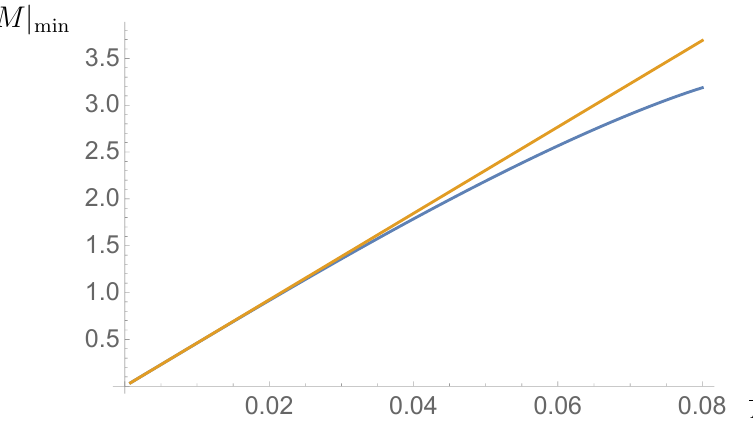
Figure 2 . The minimal value of g s M allowed for avoiding the conifold instability is plotted as a function of p=M . The yellow line represents the bound for anti-D3-branes (2.11) as considered in [16], whereas the blue line represents the bound for an NS5-brane. The NS5-brane relaxes the bound, but only